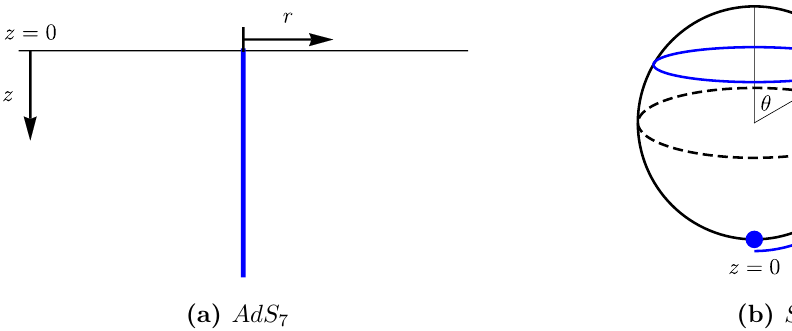
Figure 2. Cartoon of the antisymmetric (cid:13)ow embedding in AdS 7 (cid:2) S 4 . (a) In the AdS 7 factor of the geometry, the brane (the thick blue line) spans the directions ( t; x; z ) (the t and x directions are suppressed in this (cid:12)gure) and occupies r = 0. The thin, horizontal, black line in this (cid:12)gure is the boundary of AdS 7 . (b) In the UV ( z ! 0) the M5-brane collapses to the south pole of the S 4 . For non-zero z , the M5-brane wraps an S 3 at a polar angle (cid:18) ( z ) which decreases with increasing z . In the IR ( z ! 1 ) this angle tends to a value (4.6), determined by the dissolved M2-brane charge. The UV and IR solutions correspond to a bundle of M2-branes and the antisymmetric Wilson surface,